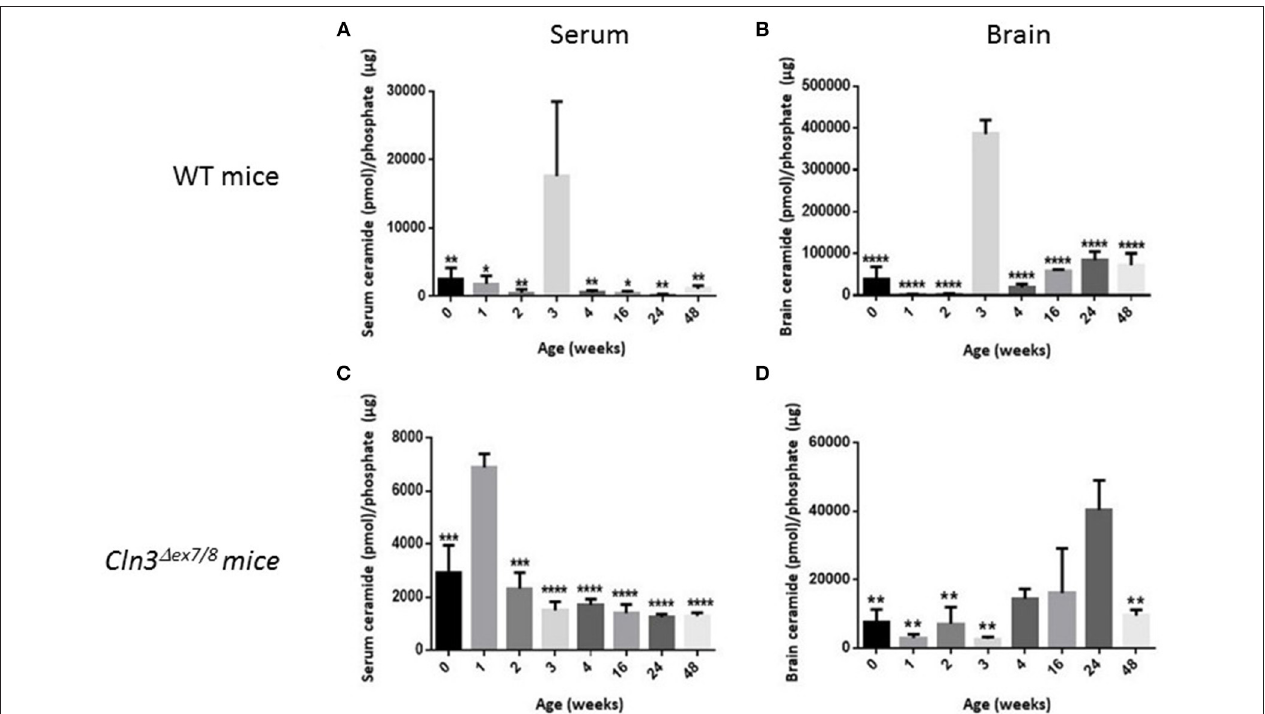
FIGURE 3 | Ceramide levels determined by DGK assay in (A) WT mouse sera at different ages in weeks (at 0w: n = 6; 1w: n = 3; 2w: n = 3; 3w: n = 3; 4w: n = 6; 16w: n = 3; 24w: n = 3; 48w: n = 3) (* P < 0.05, ** P < 0.01). (B) WT mouse brain (at 0w: n = 5; 1w: n = 3; 2w: n = 3; 3w: n = 3; 4w: n = 6; 16w: n = 3; 24w: n = 3; 48w: n = 3) (**** P < 0.0001). (C) Cln3 ∆ ex7/8 mouse sera (at 0w: n = 4; 1w: n = 3; 2w: n = 4; 3w: n = 3; 4w: n = 4; 16w: n = 4; 24w: n = 4; 48w: n = 4) (*** P < 0.001, **** P < 0.0001). (D) Cln3 ∆ ex7/8 mouse brain (at 0w: n = 4; 1w: n = 4; 2w: n = 3; 3w: n = 4; 4w: n = 3; 16w: n = 3; 24w: n = 4; 48w: n = 4) (** P < 0.01). In